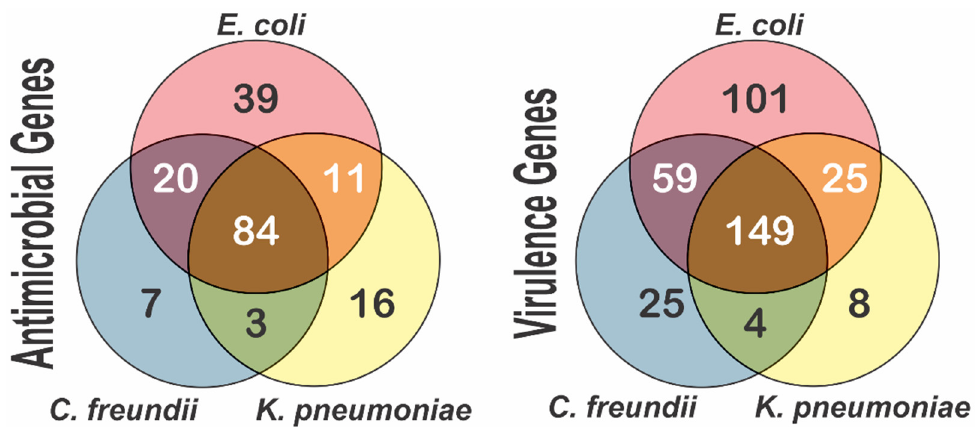
Figure 5. Venn diagram of the antimicrobial resistance and virulence genes identified in the genomes of the strains whose genomes were sequenced.